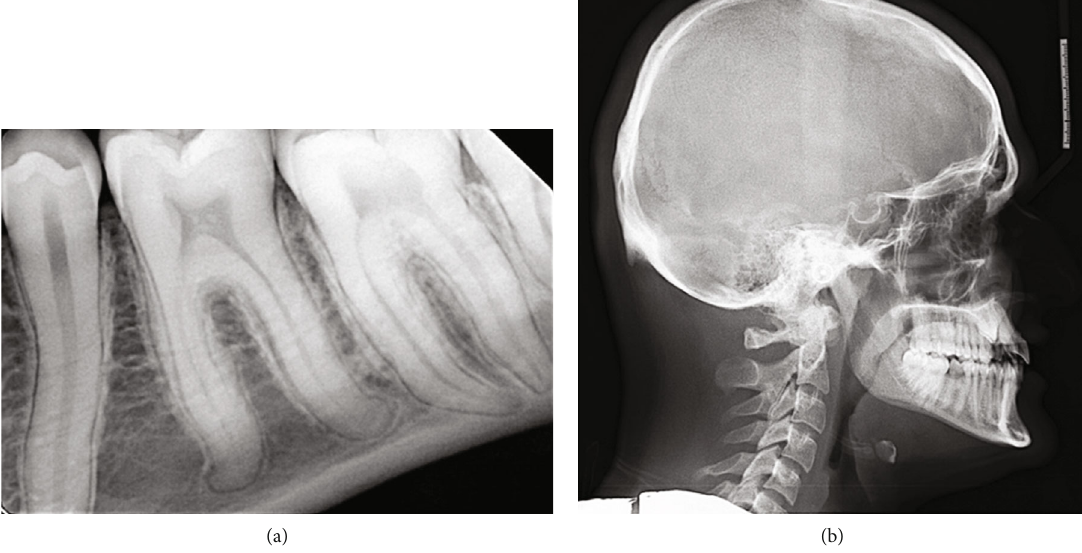
Figure 3: Periapical radiograph shows long roots of teeth #35, 36, 37 (a) and lateral cephalometric radiograph of the patient (b).